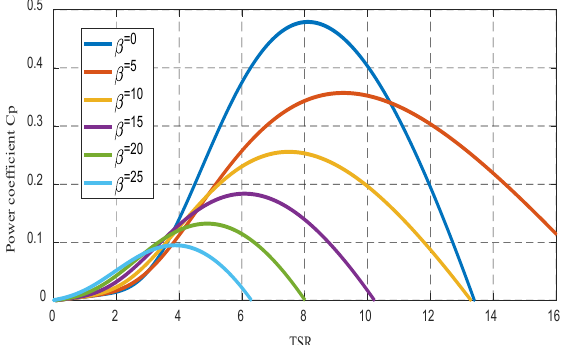
Figure 3. Power efficiency for different pitch angles and TSR.